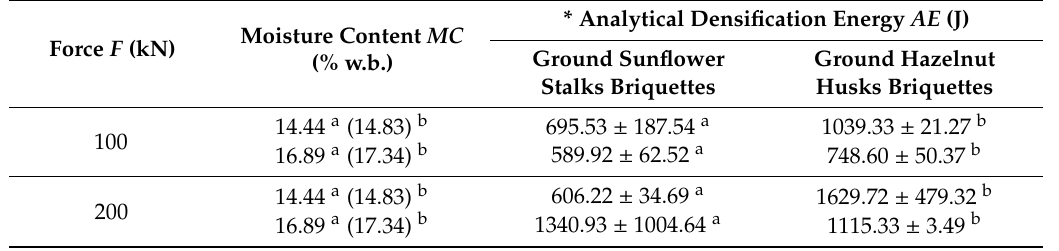
Table 14. Analytical densification energy of ground sunflower stalks and hazelnut husks for particle sizes 0–10